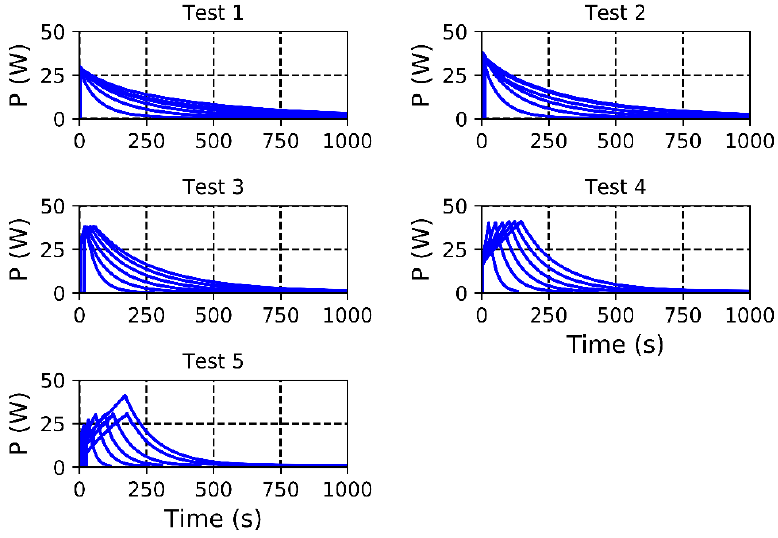
Figure 24. Power while charging according to the value of resistance.